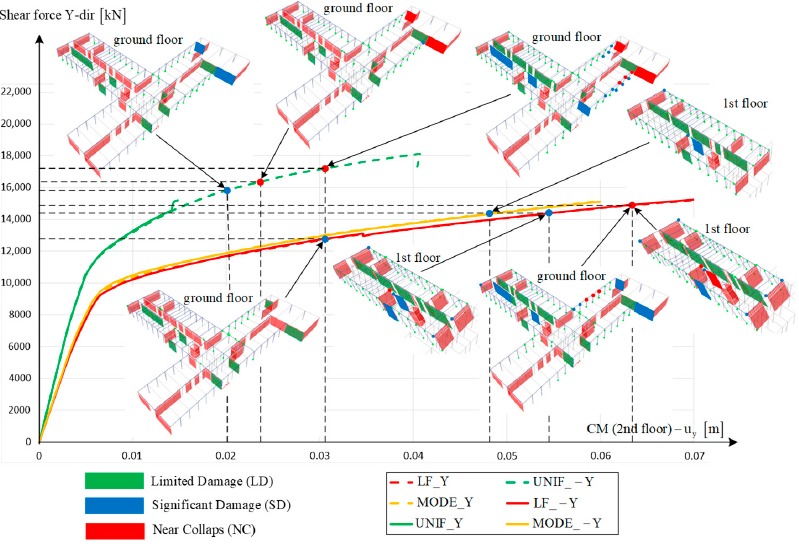
Figure 25. Pushover curves in Y-dir for retrofitted